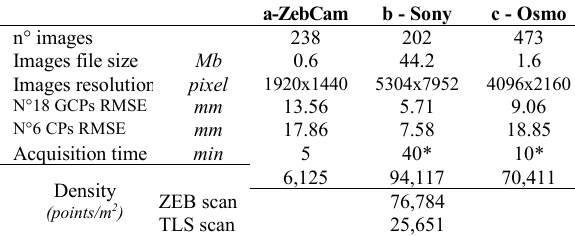
Table 4. Photogrammetric datasets specifics. (*) needs the added time value of ZEB mapping. Comparison with range- based densities.